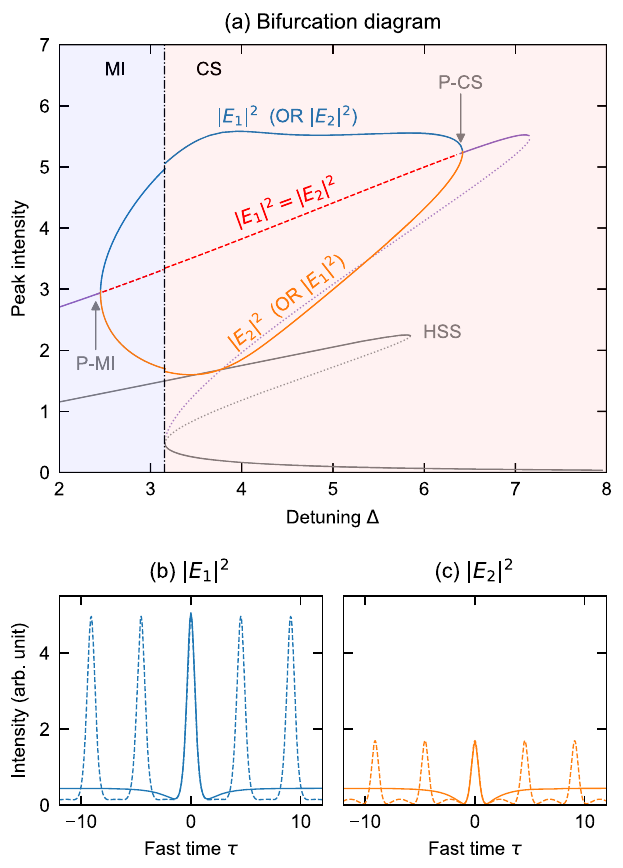
Fig. 2 Bifurcations of symmetry-broken CSs. a Bifurcation diagram showing the intensity of the homogeneous steady-state (HSS) solutions and the peak intensity of the CS and selected modulation instability (MI) pattern solutions of Eq. (1) as indicated [parameters as in Fig. 1]. The HSS solutions are symmetric at all detunings, whilst the CS and patterned solutions undergo a symmetry breaking pitchfork bifurcation at detunings 6.4 (P-CS) and 2.4 (P-MI), respectively. Solutions that are unstable against polarization symmetry breaking are indicated with red dashed lines. The unconditionally unstable CS and HSS branches are indicated by dotted lines. b and c Compare the modal intensity pro fi les for a symmetry-broken CS (solid curves) and a patterned solution (dashed curves) that both exist just beyond the up-switching point at Δ =